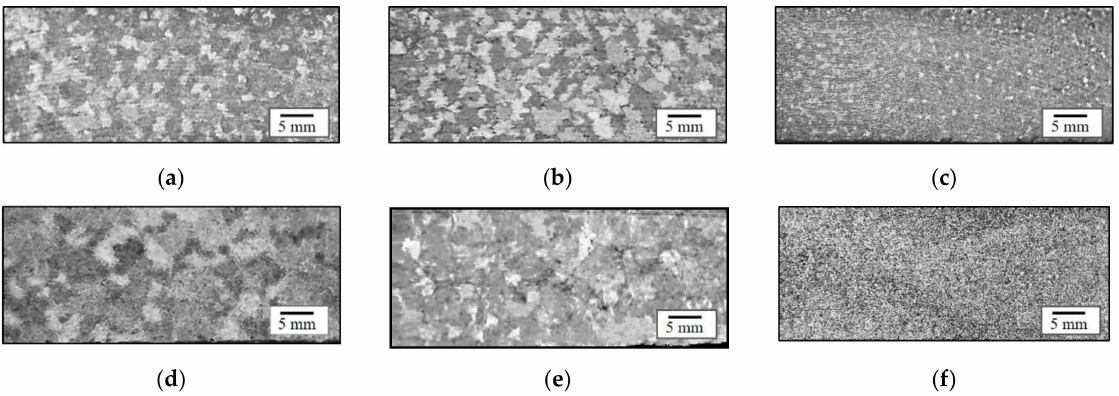
Figure 4. Macrostructure of hypoeutectic alloys: ( a ) Alloy 2, untreated; ( b ) Alloy 2, standard flux; ( c ) Alloy 2, complex flux; ( d ) Alloy 3, untreated; ( e ) Alloy 3, standard flux; ( f ) Alloy 3, complex